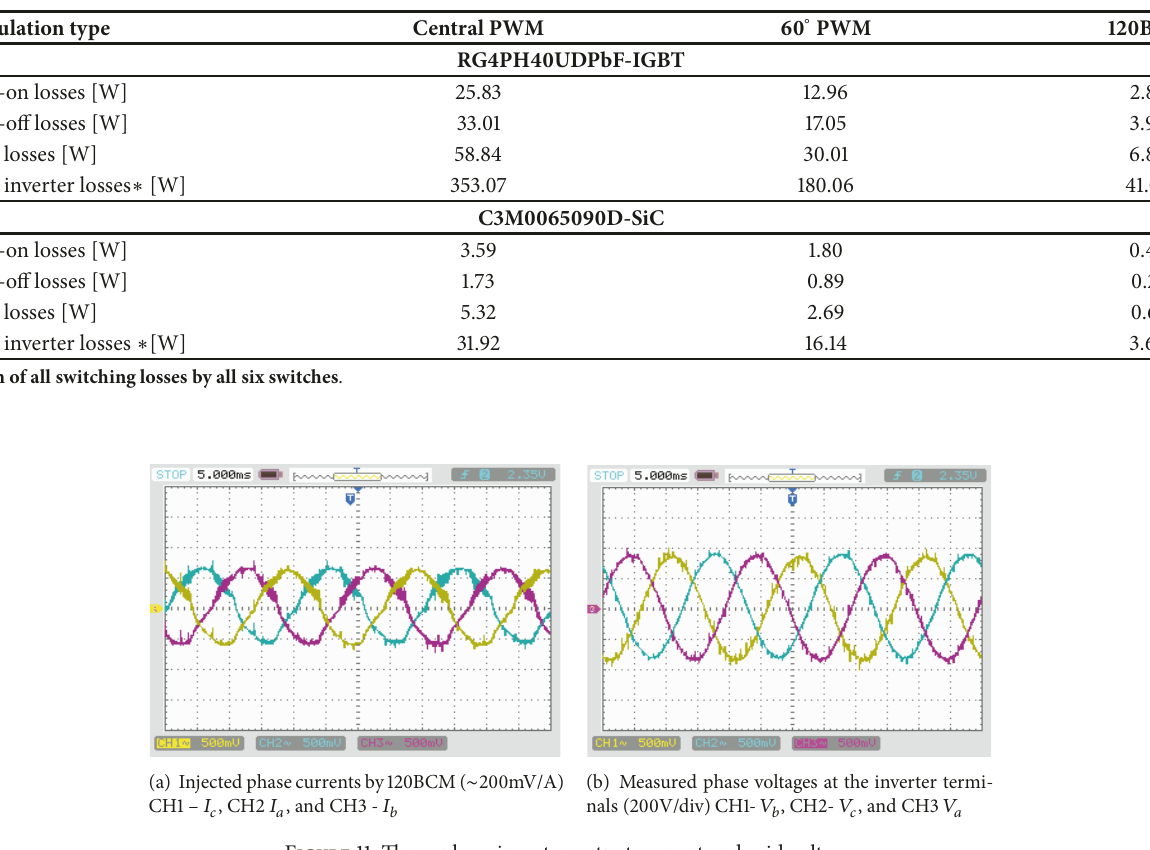
Table 5: Calculation results of the switching losses when different modulation techniques are used.